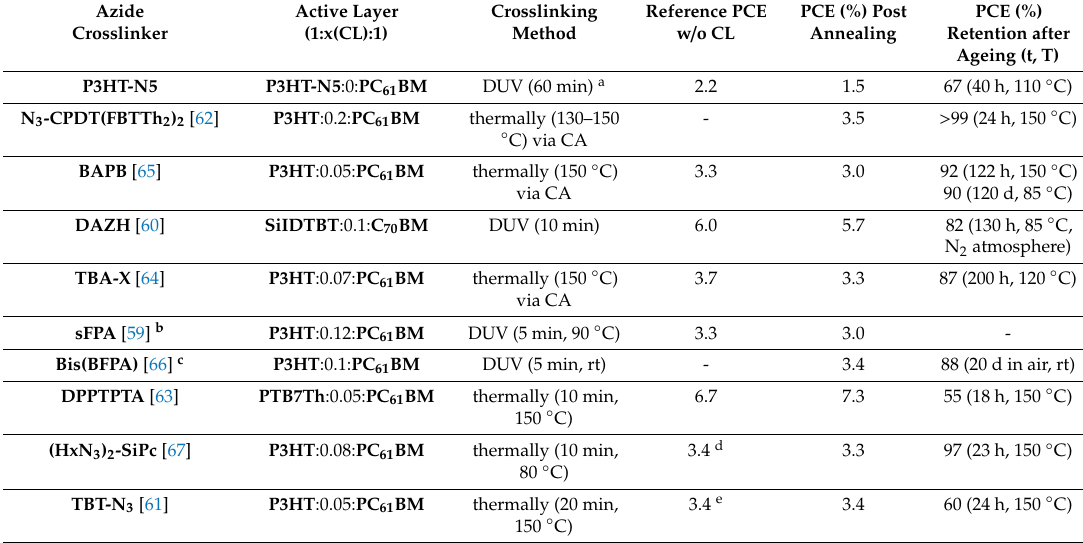
Figure 5. Left: Conventional thermal ageing of an amorphous bulk heterojunction (BHJ) blend (center) leads to macrophase separation over time. Right: Photo-crosslinking of the polymer prior to ageing fixates the chains in space and prevents fullerene aggregation. Table 1. Performance of organic photovoltaic (OPV) devices where active layer crosslinking with organic azides was employed. PCE: power conversion efficiency.